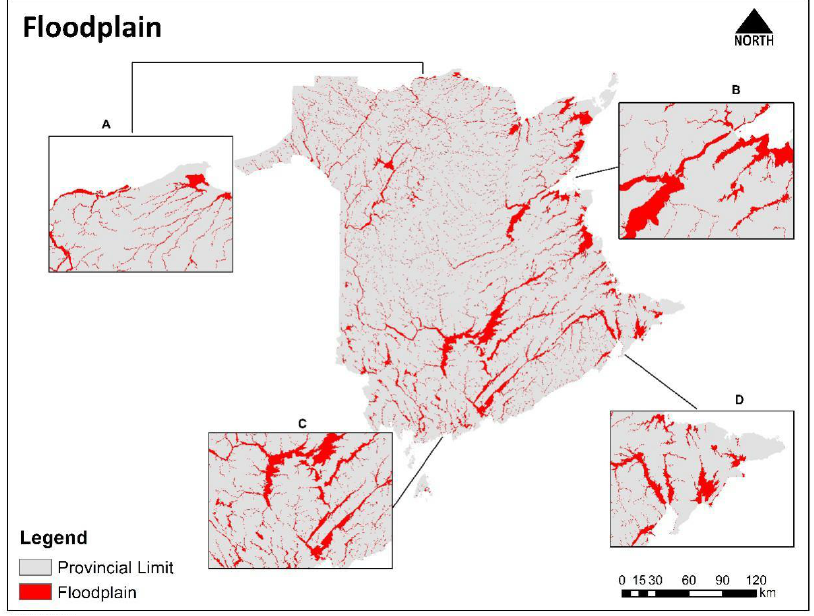
Figure 4. Floodplain generated with GFA.